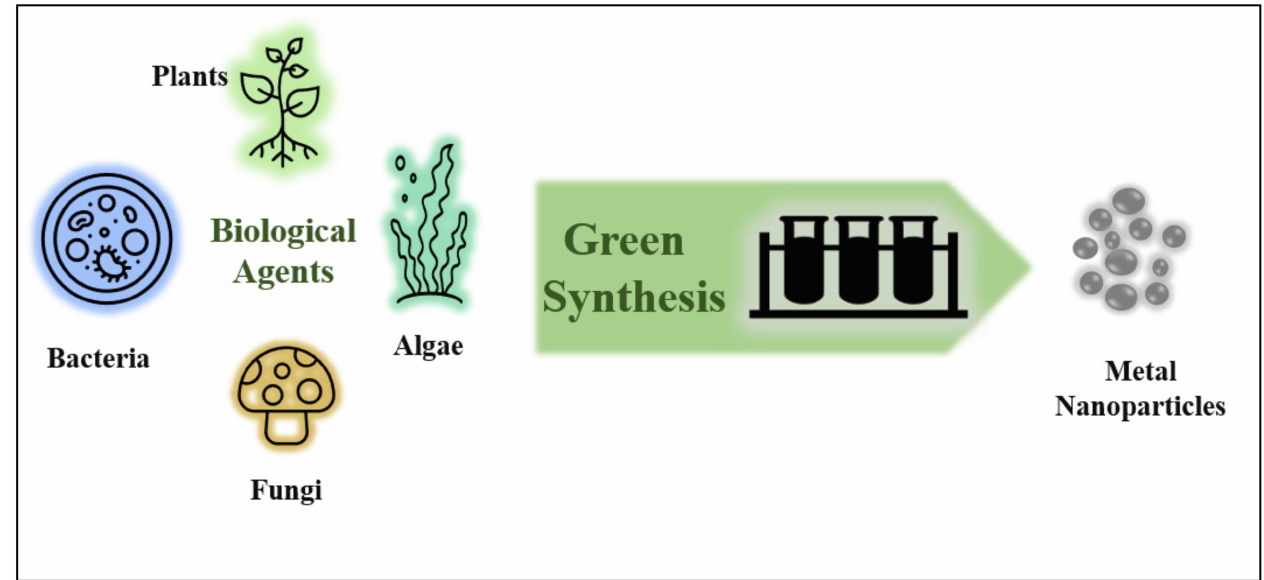
Figure 2. The green synthesis method using several unicellular (bacteria, algae) and multicellular (plants, fungi) biological agents—a system in which these agents are utilized to generate nanostructures of metals in one